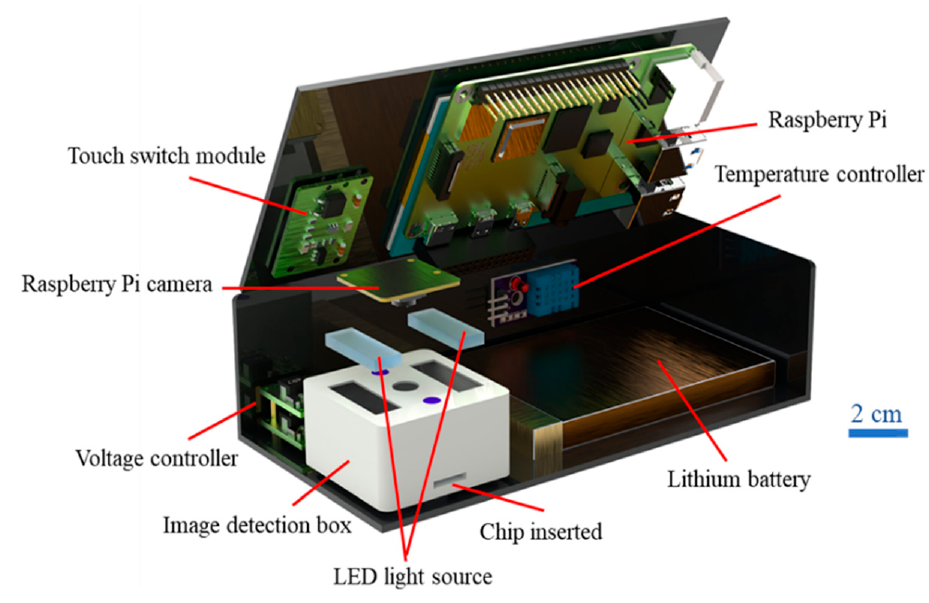
Figure 2. Main components of hand-held detection system.